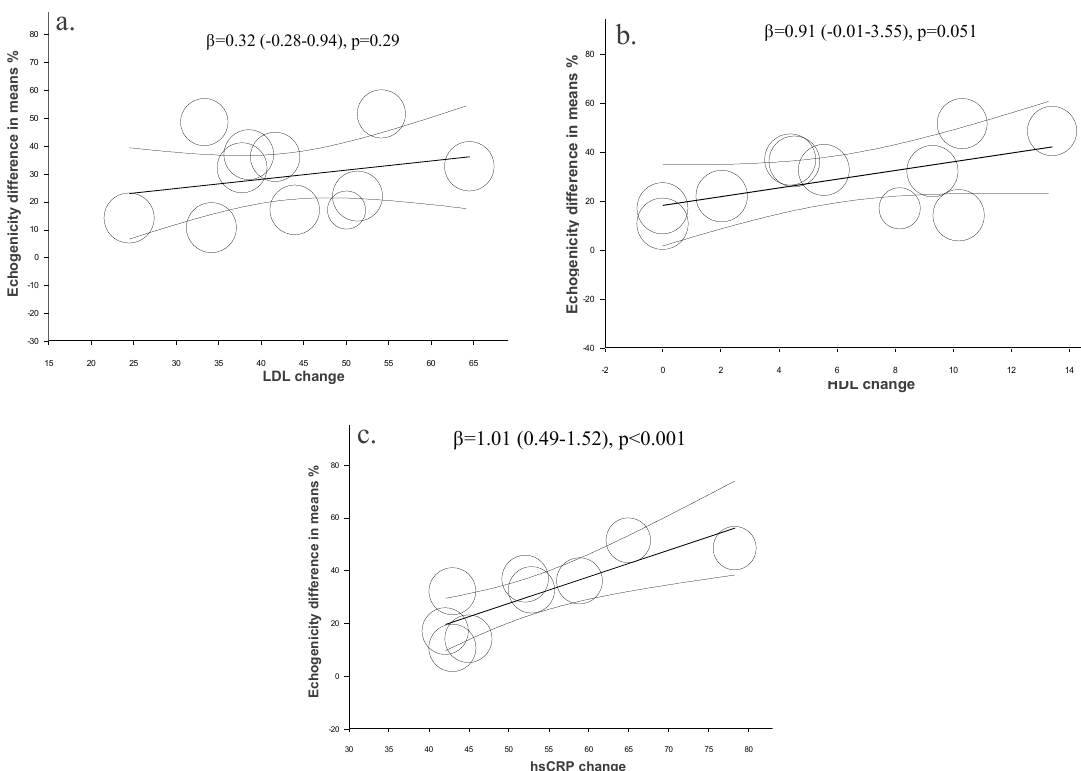
Figure 2. Effects of statin on plaque echogenicity. Note: Kadaglou 2009 [17] has divided and analyzed patients in two groups: the first group ( * ) was on statin, but underwent contralateral carotid artery stenting (CAS), and the second group ( ** ) was treated only with statins. Kadaglou 2010 [18] has divided and analyzed patients into two groups: the first group (^) received atorvastatin 10–20 mg, and the second group (^^) atorvastatin 80 mg.